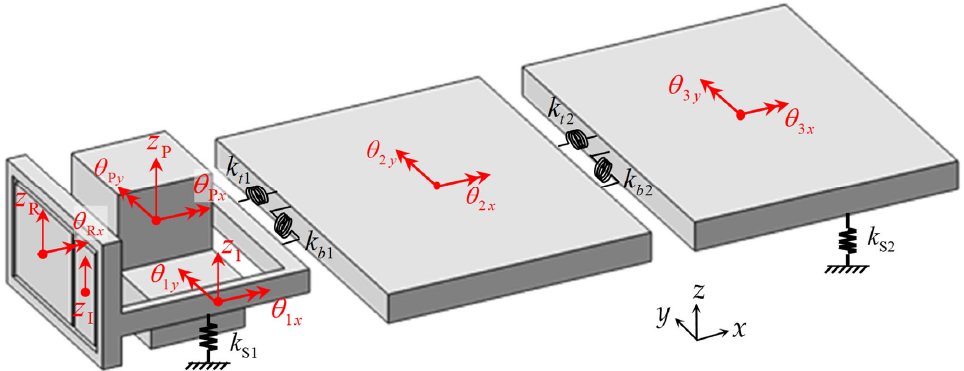
Figure 9. Dynamic model of a diesel SUV with 13 degrees of freedom.